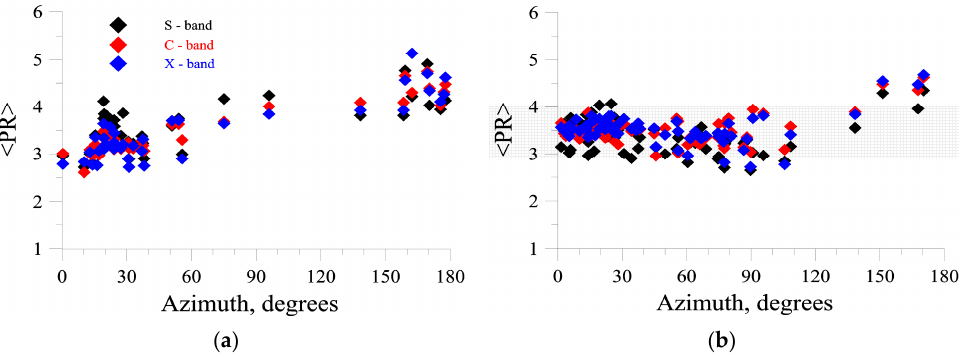
Figure 8. Polarization ratiovs. azimuth angle (0 ˚ corresponds to the upwind sensing direction). Weak winds ( a ), moderate winds ( b ). Black symbols—X-band, red—S-band, blue—C-band.